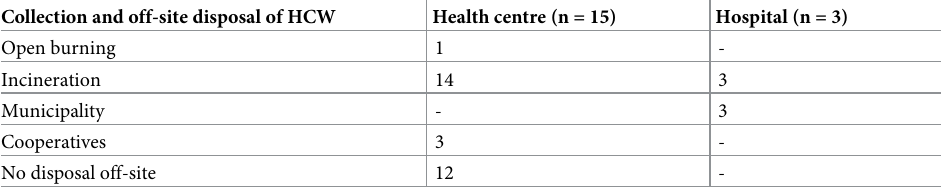
Table 16. Collection and off-site disposal of HCW from the study health facilities, Addis Ababa City Administra- tion, February 2018. Collection and off-site disposal of